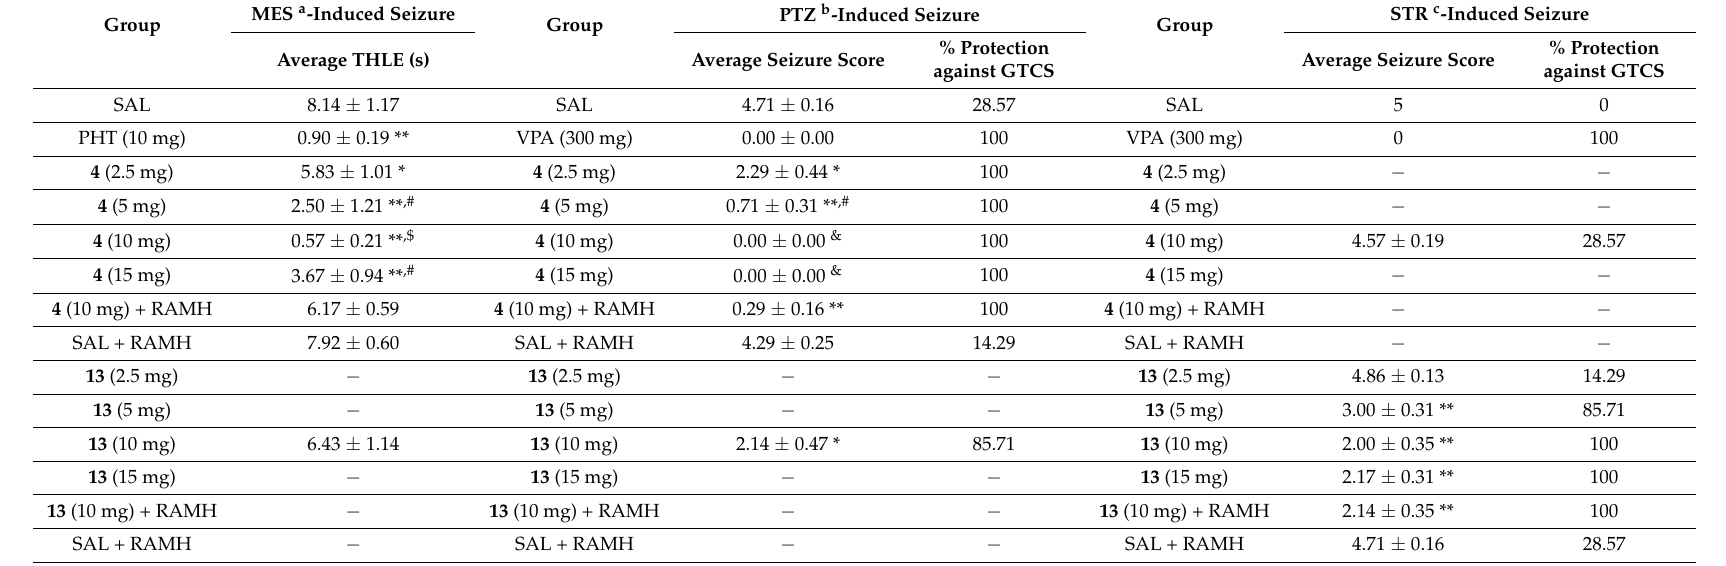
Table 3. Effects of H3R antagonists 4 and 13 on THLE duration, average score, and percentage of provided protection against generalized tonic-clonic seizure (GTCS) in MES-, PTZ-, and STR-induced convulsion